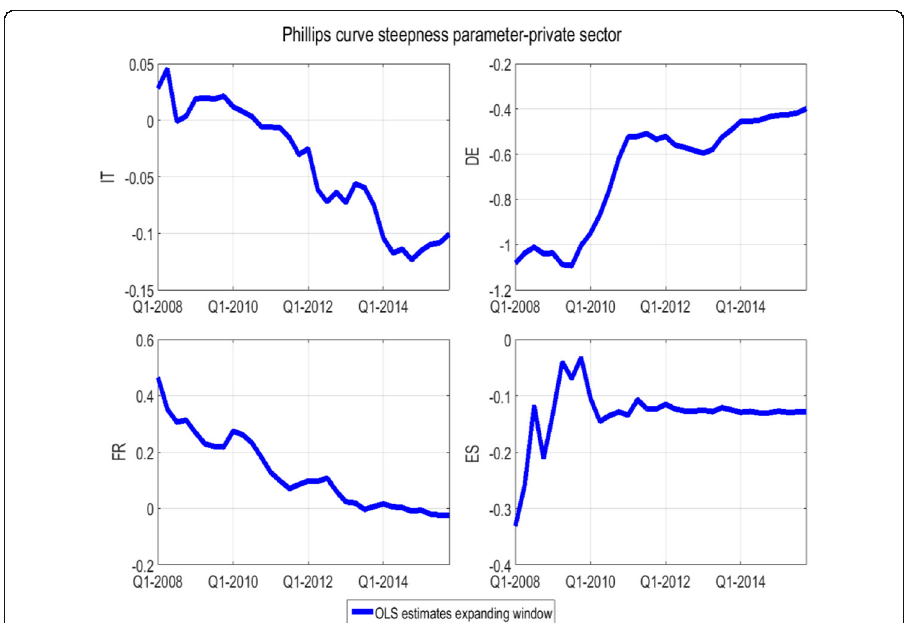
Fig. 3 Phillips curve expanding window regressions in the euro area countries. The blue lines show the OLS estimates of the parameter of unemployment rate for different samples: the first point refers to the sample 1999Q1 – 2008Q1 and the last point refers to the sample 1999Q1 –